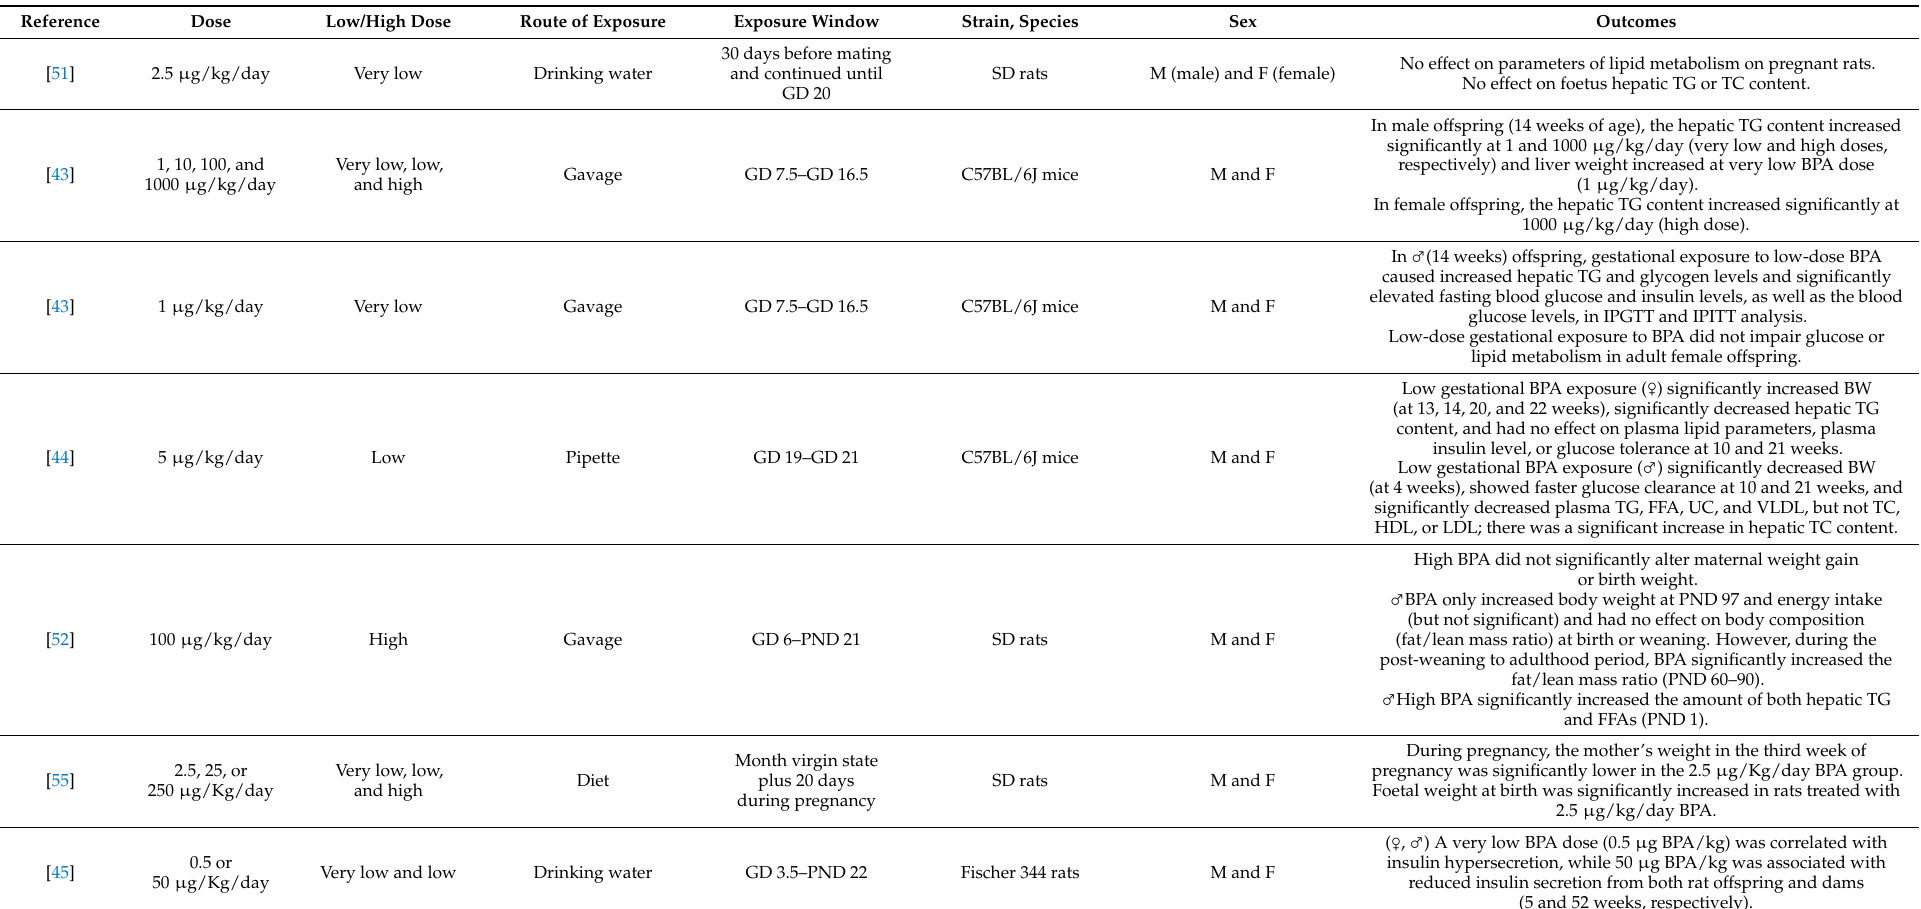
Table 2. Metabolic parameters observed in animal studies following prenatal exposure to bisphenol